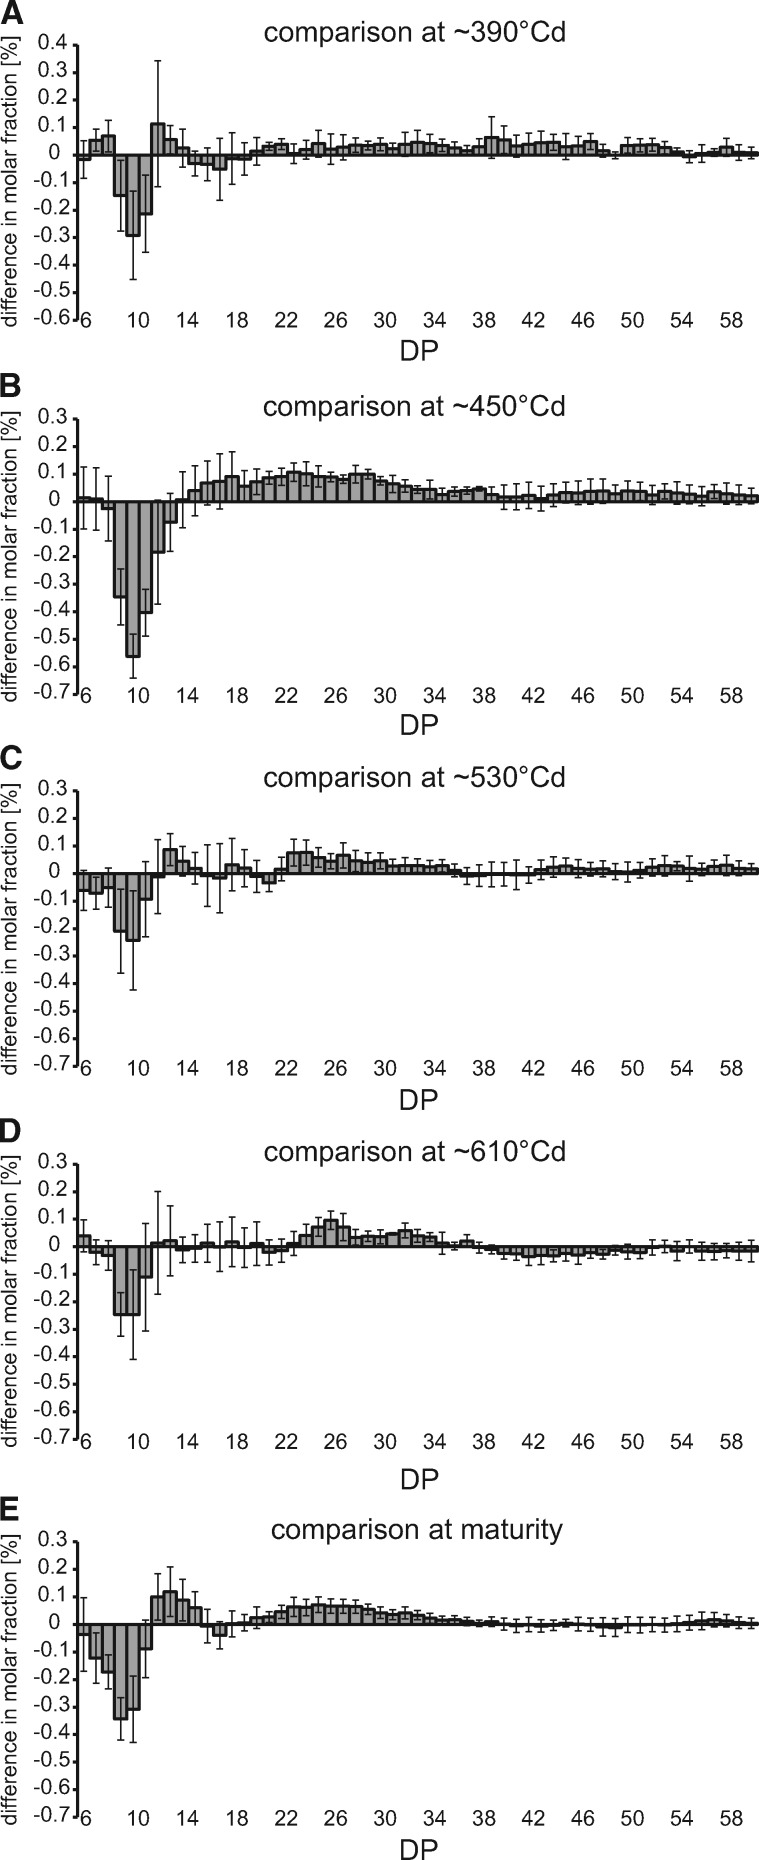
Heat-induced changes in amylopectin structure. Comparison of chain length distributions of debranched amylopectin between grains from plants grown under control and heat wave conditions at time points comparable in terms of �Cd. Positive bars reflect an excess of those chains in heat wave grains. (A) Heat wave at 393�Cd minus control at 384�Cd; (B) heat wave at 441�Cd minus control at 464�Cd; (C) heat wave at 521�Cd minus control at 544�Cd; (D) heat wave at 601�Cd minus control at 624�Cd; (E) heat wave at maturity minus control at maturity.